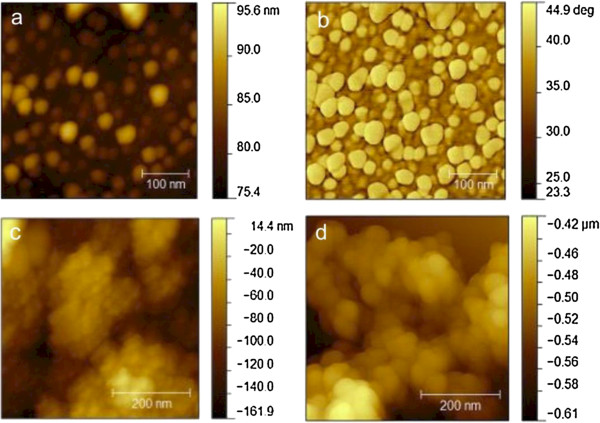
AFM images of the films. (a) The AFM topography image and (b) the corresponding AFM phase image of the ITO/nc-TiO2 film. The AFM topography images of (c) the ITO/nc-TiO2/CdS(5) film and (d) the ITO/nc-TiO2/CdS(15) film.